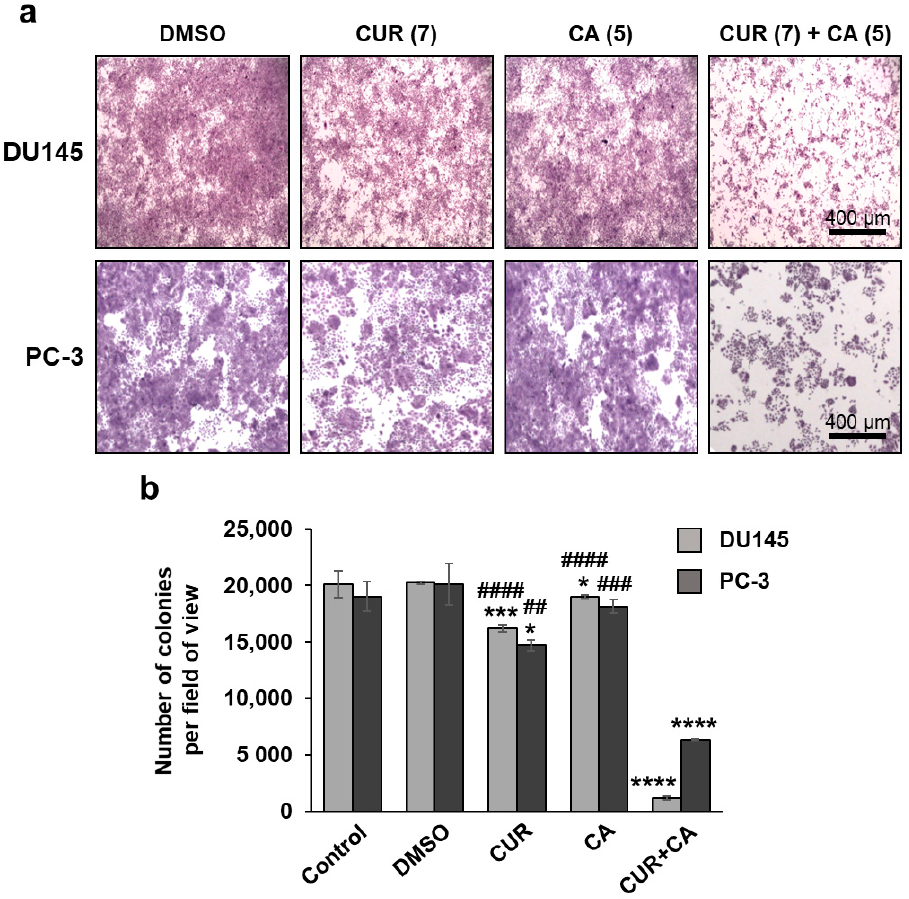
Figure 3. Colony formation analysis of the effects of curcumin and carnosic acid on cell growth. ( a ) Representative images of Crystal Violet-stained cell colonies obtained after 7 days of cell exposure to the indicated concentrations (in µ M) of curcumin (CUR), carnosic acid (CA) and their combination (CUR + CA). Magnification: 40×; scale bar: 400 µm. ( b ) Quantitative evaluation of the colony formation data. The data are presented as averaged numbers of colonies per microscopic field of view (mean ± SEM; n = 3). Statistically significant differences for CUR, CA or CUR + CA vs. DMSO (* p < 0.05; *** p < 0.001 and **** p < 0.0001) and for CUR or CA applied separately vs. CUR + CA (## p < 0.01; ### p < 0.001 and #### p < 0.0001).